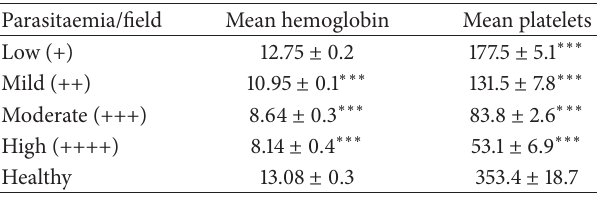
Table 3: The level of hemoglobin and platelets in patient P. falciparum malaria with parasitaemia.